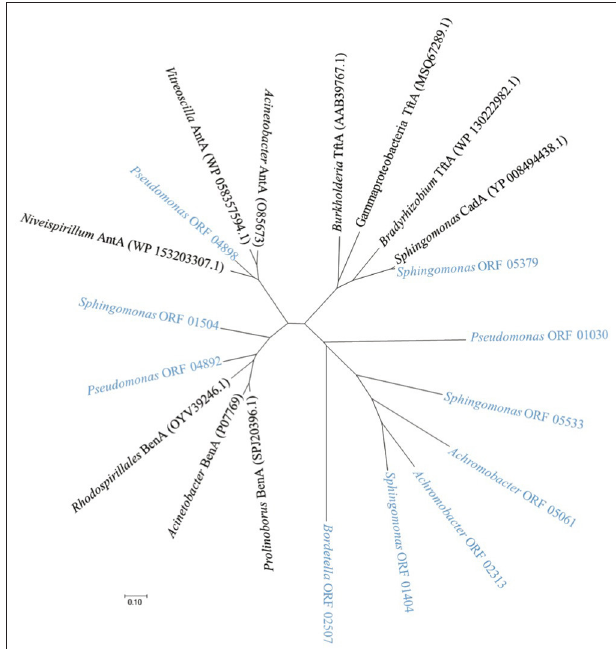
FIGURE 3 | Dendrogram showing the relatedness of relevant TftA homologous sequences of the four isolated species (names in light blue) along with reference protein sequences from KEGG and NCBI databases (names in black). Homologs include CadA, BenA, and AntA sequences from the KEGG database along with their best-matching counterparts in α -, β -, and γ -proteobacteria. The dendrogram was obtained by the neighbor-joining method using MEGA 7 based on sequence alignments calculated by CLUSTAL W using the default options. Bradyrhizobium TftA (WP_130222982.1): Bradyrhizobium sp. Leo121, Burkholderia TftA (AAB39767.1): Burkholderia cepacia , Gammaproteobacterial TftA (MSQ67289.1): Gammaproteobacterium, Rhodospirillales BenA (OYV39246.1): Rhodospirillales bacterium 20-64-7, Prolinoborus BenA (SPJ20396.1): Prolinoborus fasciculus , Acinetobacter BenA (P07769): Acinetobacter calcoaceticus , Niveispirillum AntA (WP_153203307.1): Niveispirillum sp. SYP-B3756, Vitreoscilla AntA (WP_058357594.1): Vitreoscilla massiliensis , Acinetobacter AntA (O85673): Acinetobacter baylyi ADP1, Sphingomonas CadA (YP_008494438.1): Sphingomonas sp. ERG5 and isolates Pseudomonas ORF 1030, ORF 4892, ORF 4898: P. aeruginosa BT1 2.2, Sphingomonas ORF 5533, ORF 1504, ORF 5379, ORF 1404: S. histidinilytica BT1 5.2, Bordetella ORF 2507: B. petrii BT1 9.2, Achromobacter ORF 2313, ORF 5061: A. xylosoxidans BT1